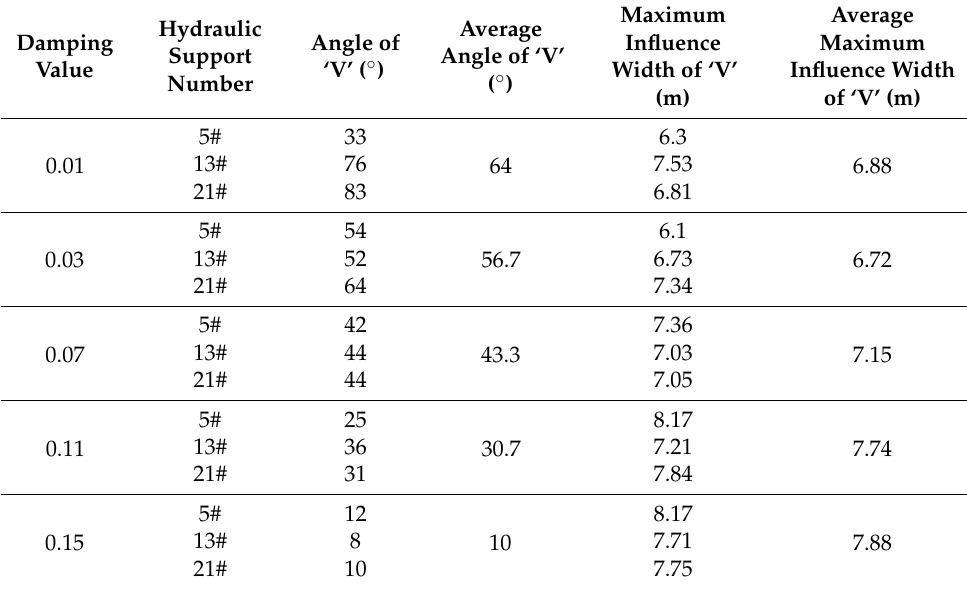
Table 4. Characteristics of top-coal drawing funnel after level 2 caving.